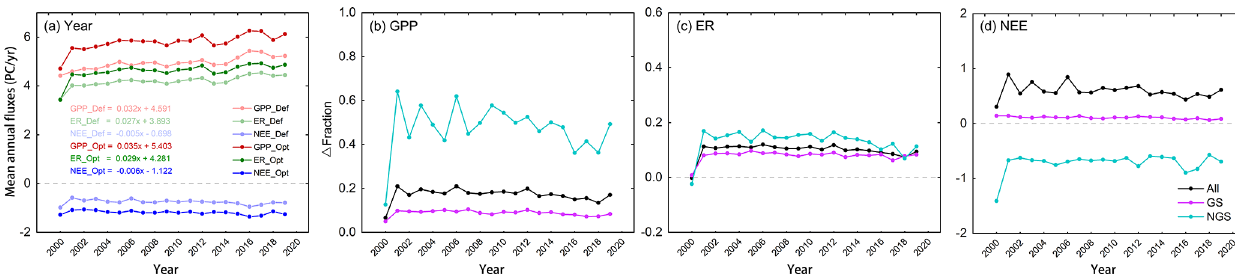
Figure 12. Temporal variations of each carbon flux (GPP, NEE, and ER) over the deciduous forests in the eastern US (2000–2019). (a) shows the interannual variation before and after parameter optimization. (b) – (c) represent the fraction changes after optimization, where positive fraction indicates an increase from the default fluxes and negative value indicates a decreasing